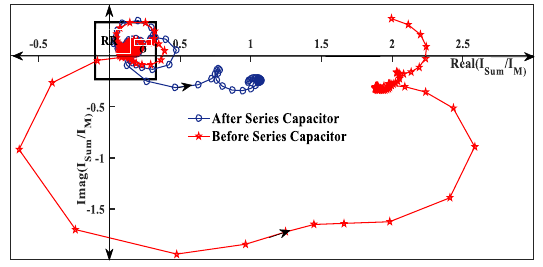
Fig. 12 a CT primary phase current (kA) ( b ) CCR during three-phase fault in power swing condition